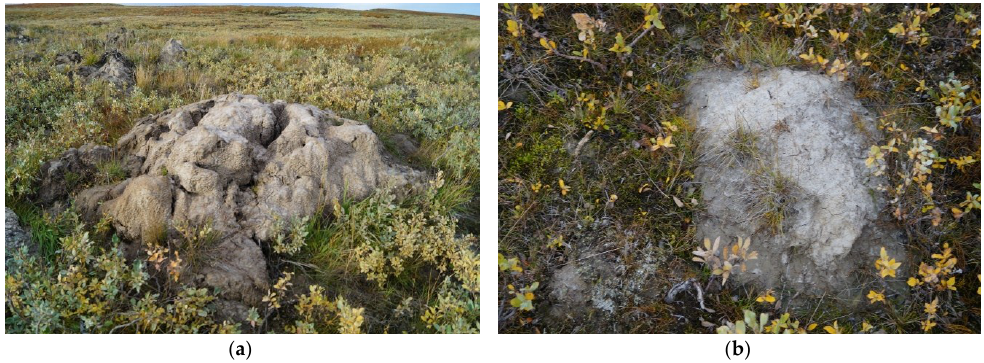
Figure 3. Remains of the ejected deposits at GEC-2, which formed piles: ( a ) pile 2–2.5 m in diameter and relative height of 0.6 m, located between impact hollows 9 and 10 (Figures 7 and 8), 53 m to the NE of the apex of the mound-predecessor (AMP); ( b ) a pile 0.4 m in diameter, and a relative height of 0.15 m, barely protruding above the surface, located 83 m NW of the AMP (photograph by E. A. Babkina, September 2017).